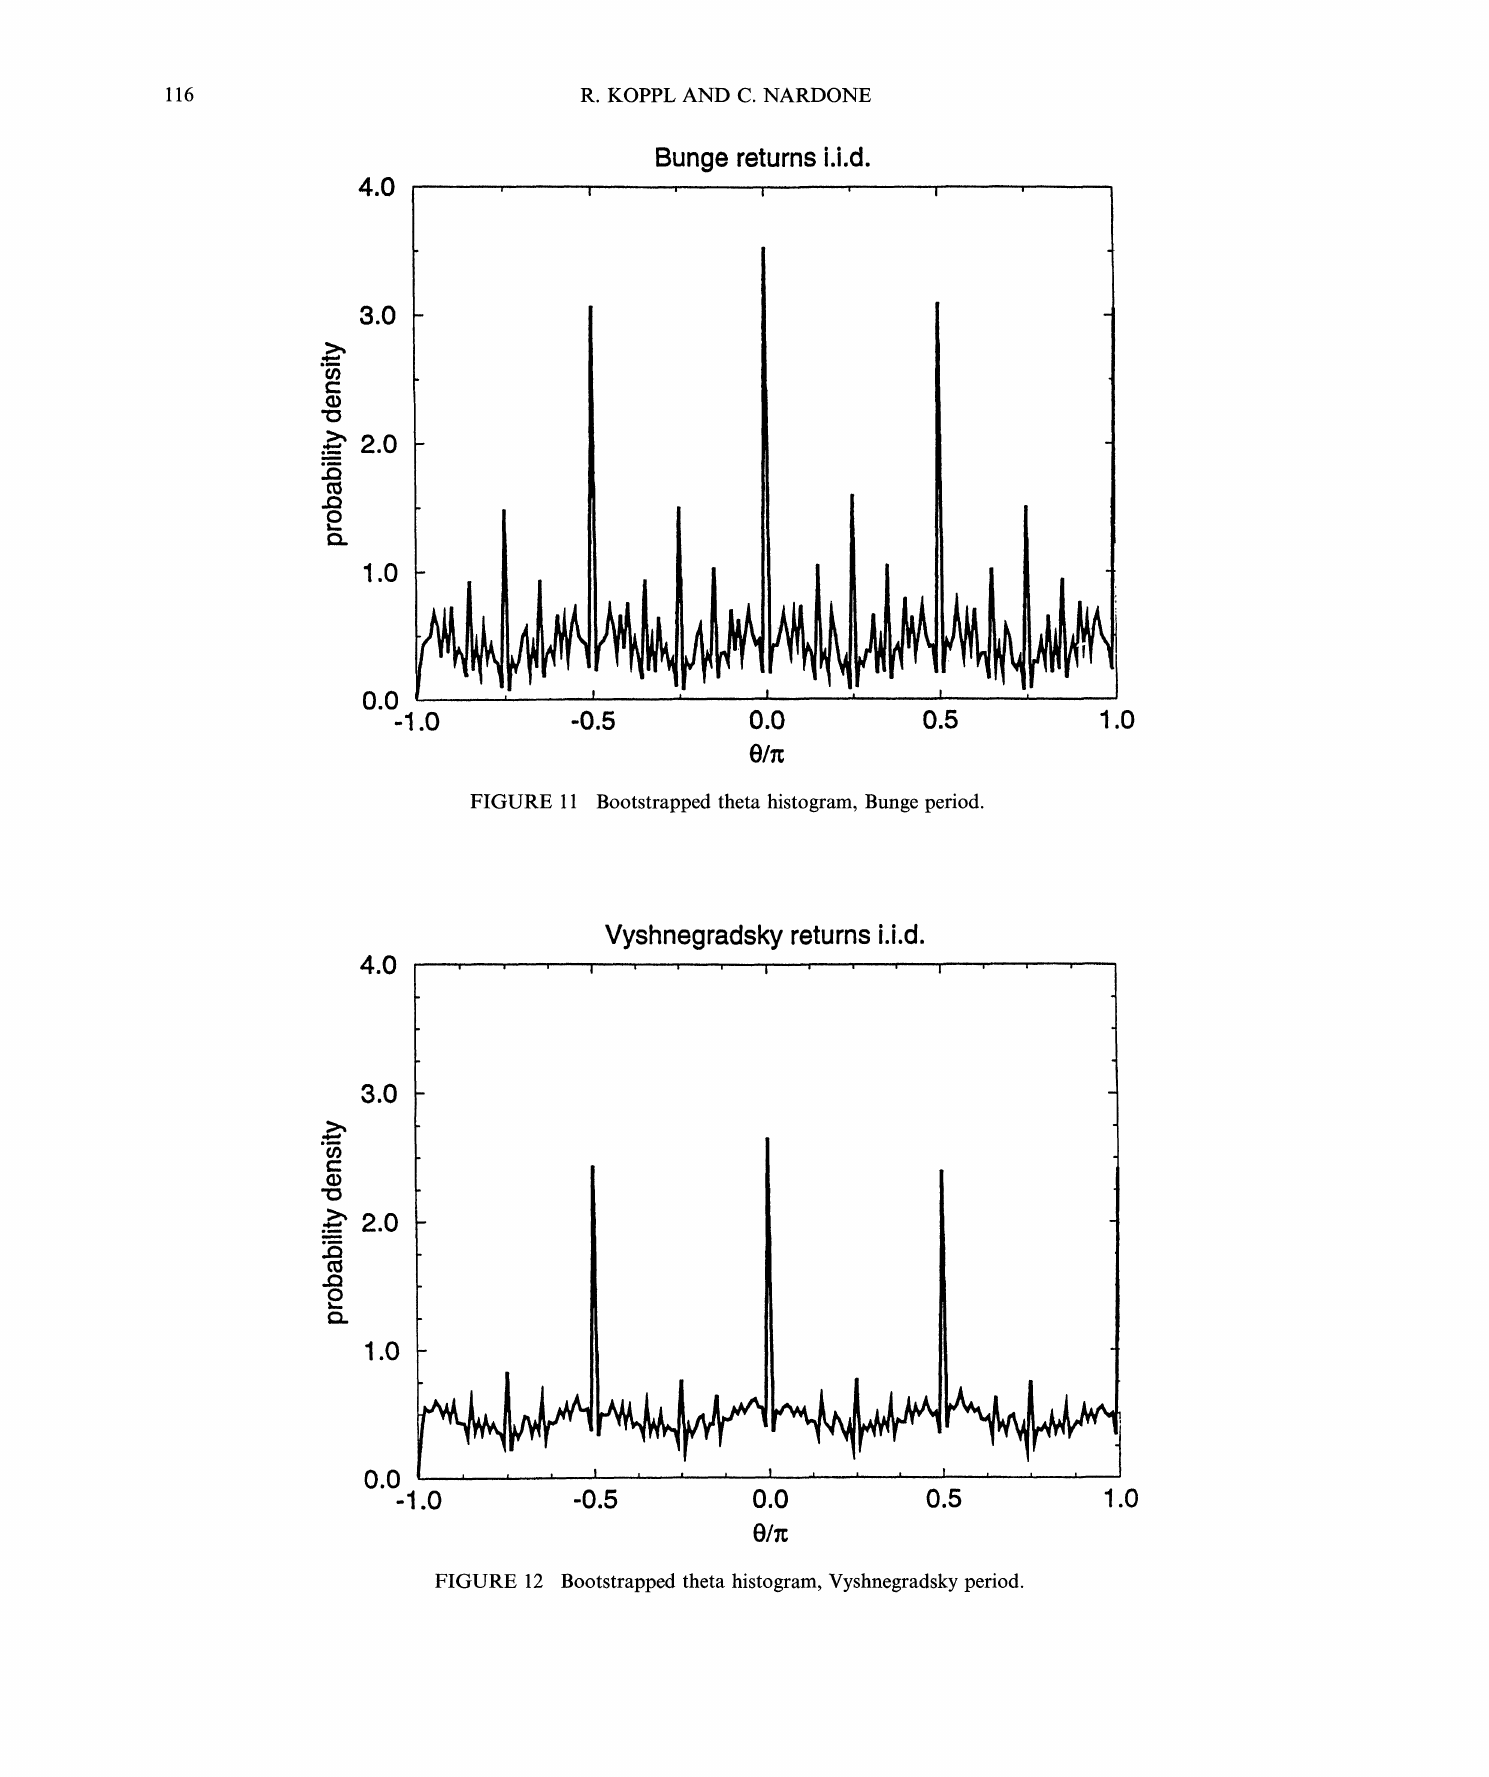
FIGURE 12 Bootstrapped theta histogram, Vyshnegradsky